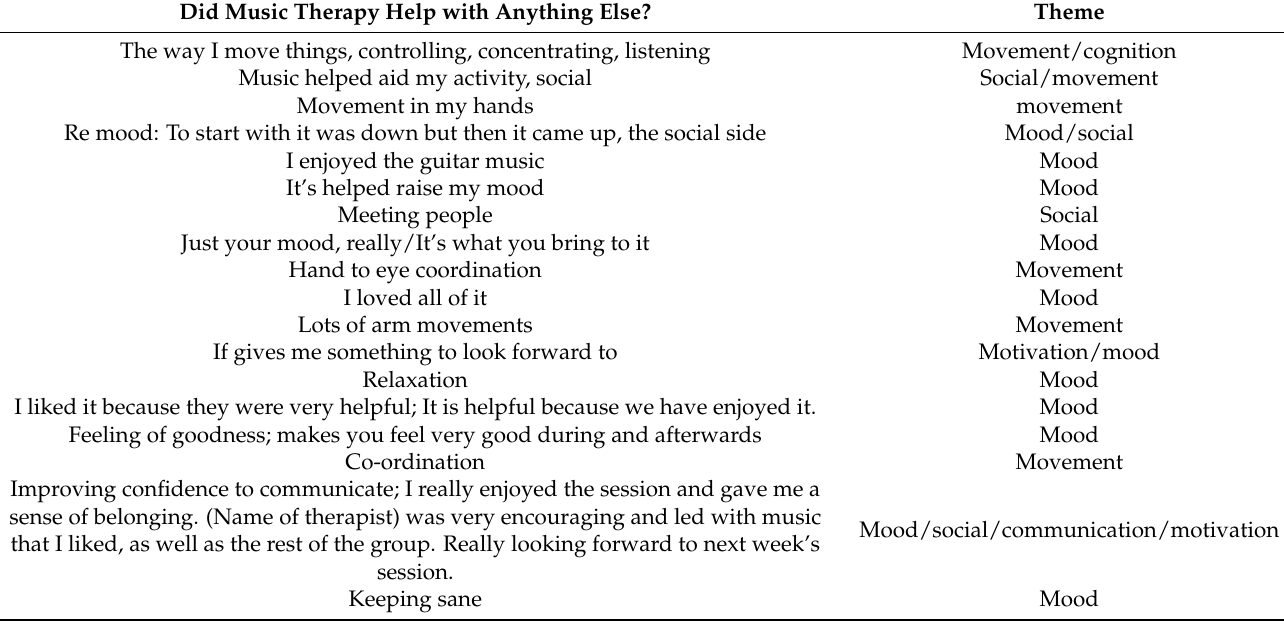
Table A1. Patients’ qualitative response to feedback questionnaires ( n =